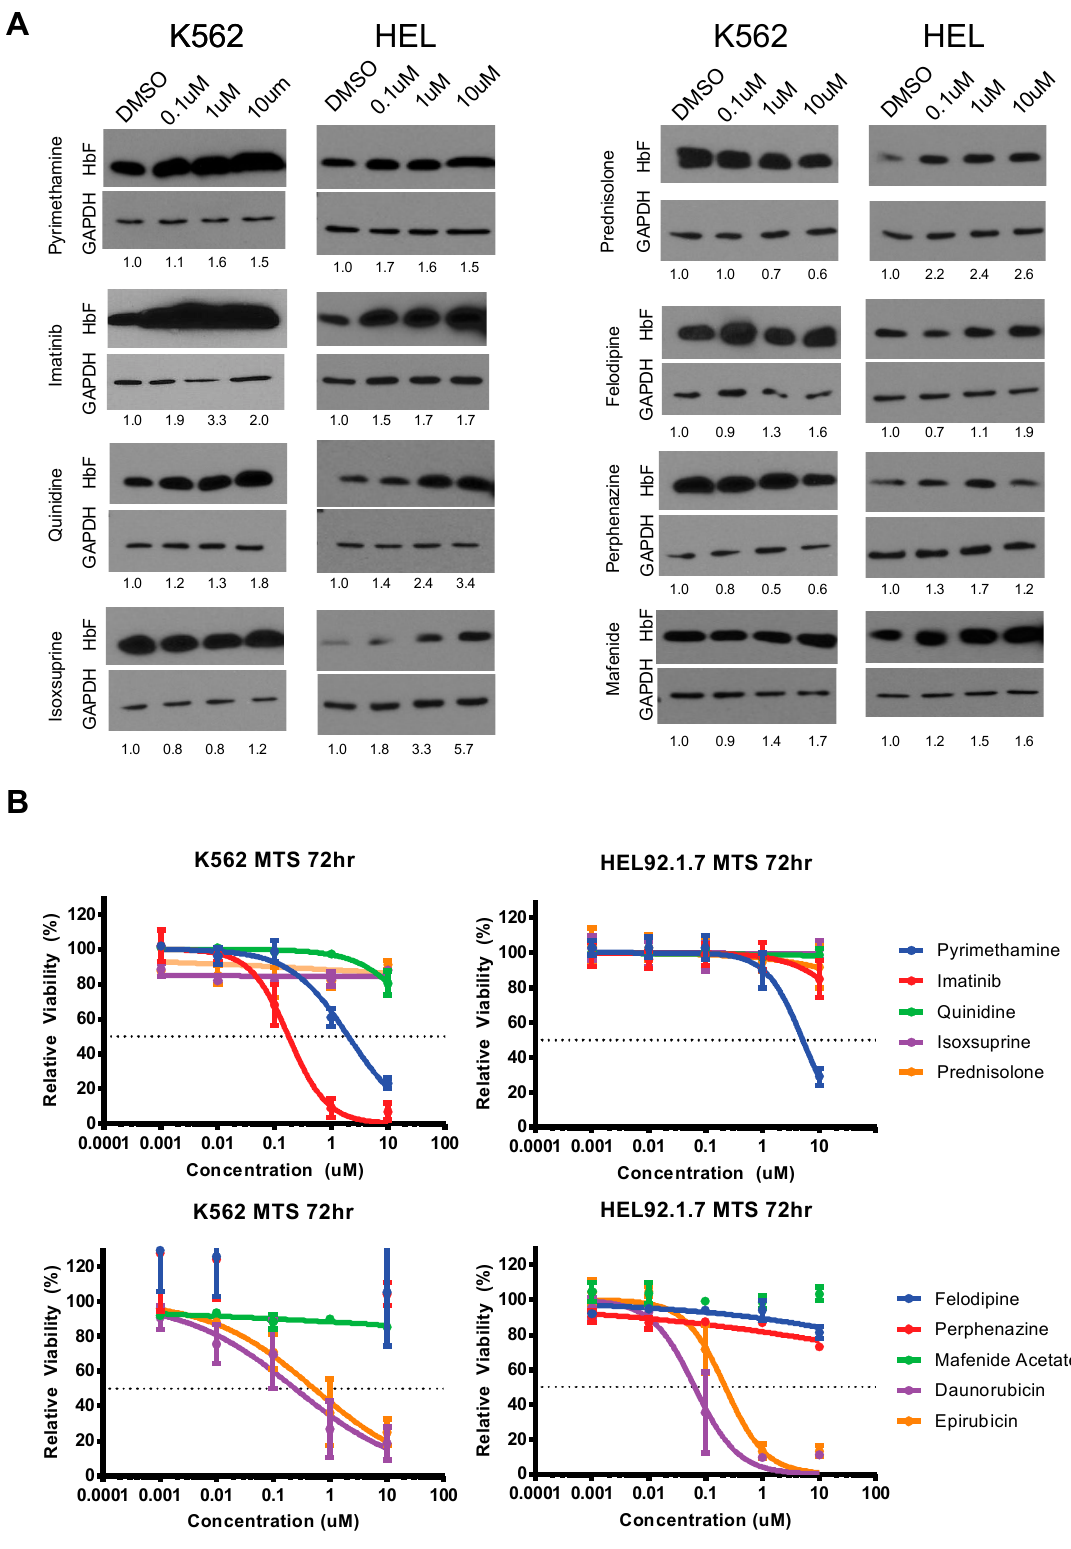
Figure 3. HbF and cytotoxicity profile of overlapping screen hits on K562 and HEL92.1.7 cell lines. ( A ) Immunoblot validations of screen candidates in K562 and HEL92.1.7 cell lines normalized to DMSO; ( B ) MTS viability assays of screen candidates in K562 and HEL92.1.7 normalized to DMSO.